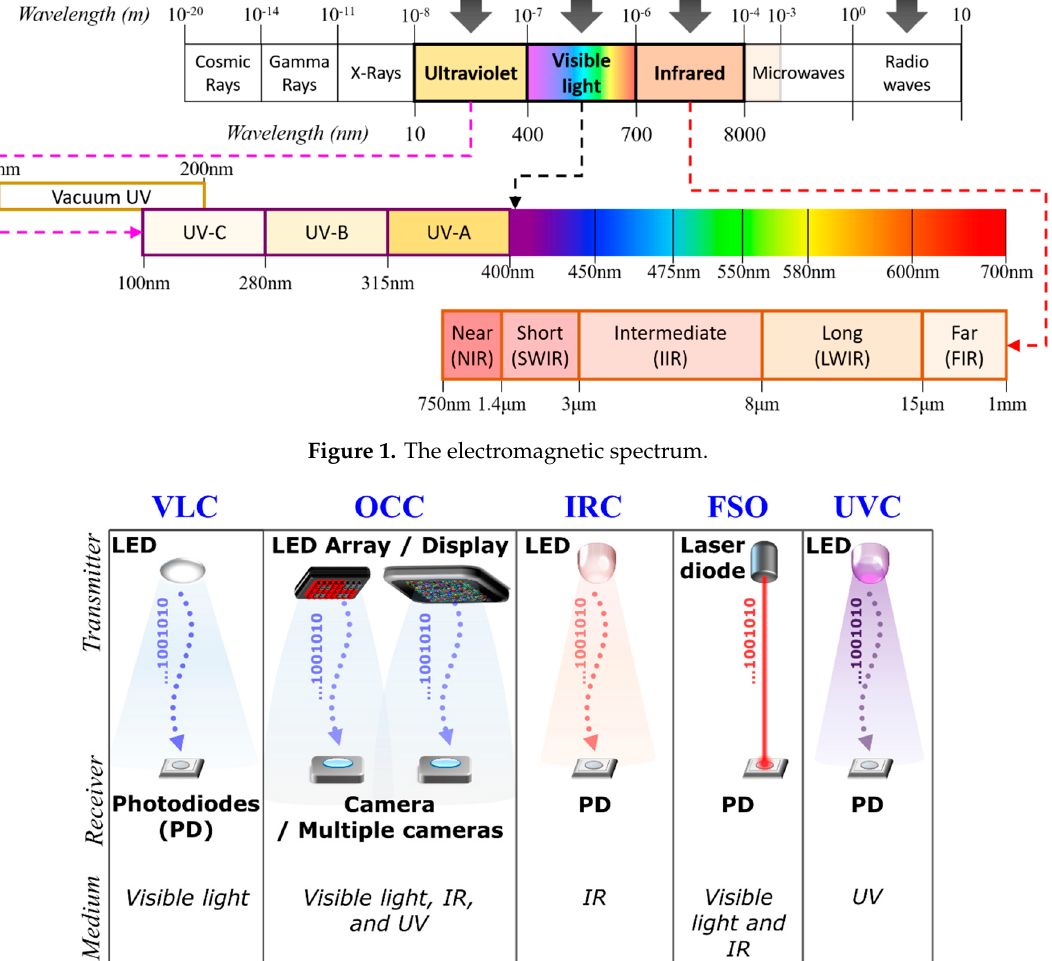
Figure 2. Overview of optical wireless communications (OWC) transmission schemes.